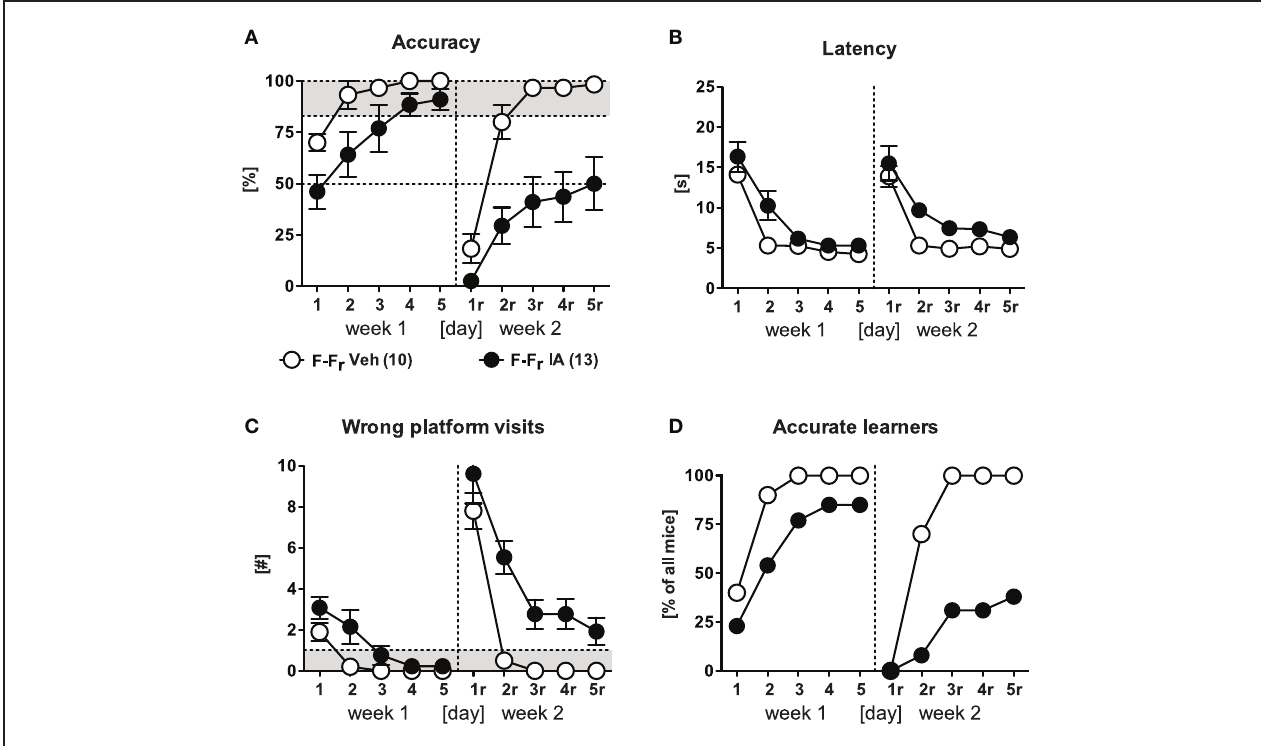
FIGURE 6 | Free choice learning and relearning in HPC-lesioned animals. IA mice and Veh controls underwent free choice learning in the 1st week and free choice learning in the 2nd week (F-F r ). (A,D) IA mice could not acquire the free choice task in the 2nd week as shown by low accuracy values [ Treatment: F ( 1 , 21 ) = 20 . 02, p < 0 . 001]